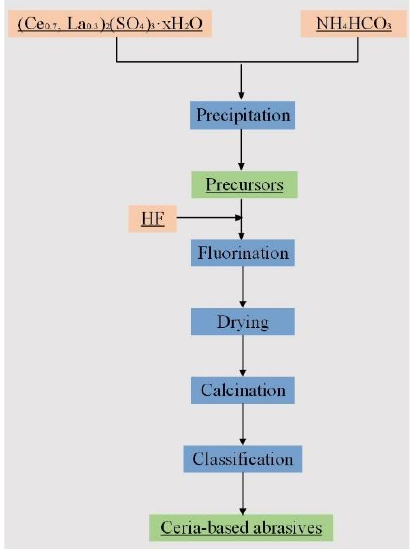
Figure 1. Schematic diagram of the synthesis of ceria-based abrasives.